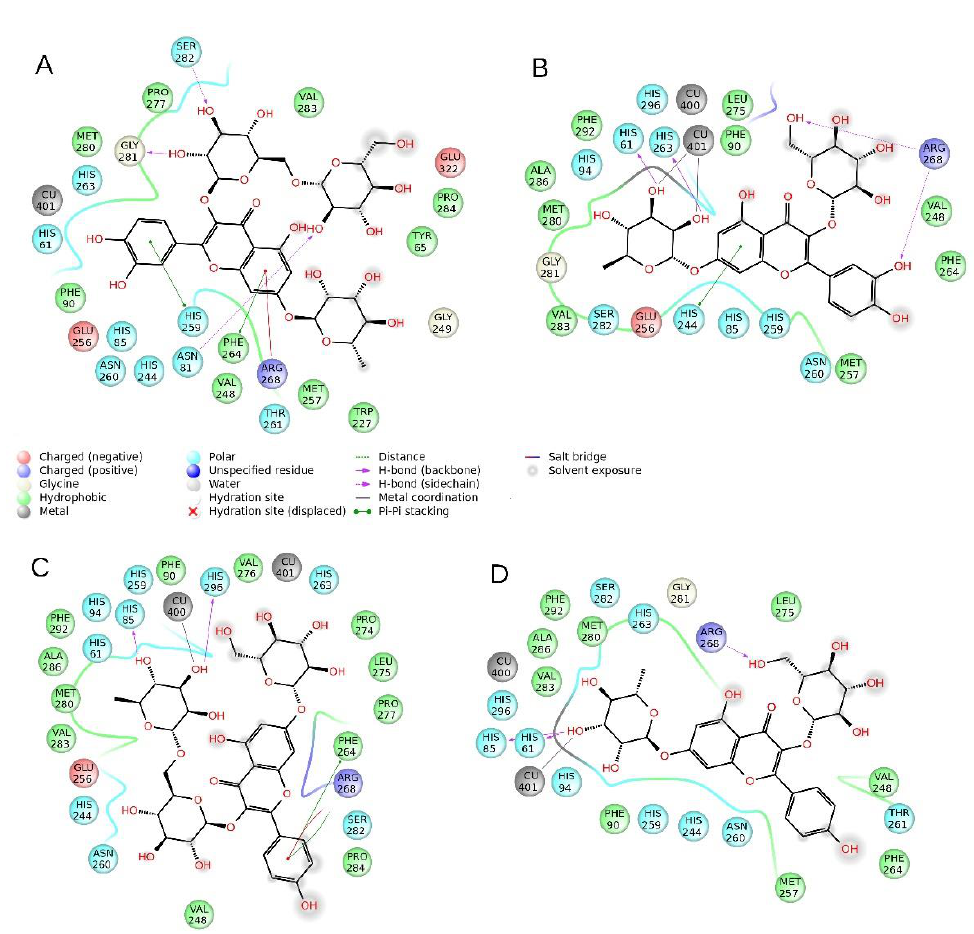
Figure 2. Interaction diagrams of compounds 11 (quercetin-di-Hex-dHex) ( A ), 12 : quercetin-Hex-dHex ( B ), 13 : Kaempferol-Hex-Rut ( C ), and 14 : kaempferol-dHex-Hex ( D ), identified in the sea rocket ( Cakile maritima ) extracts, docked to tyrosinase.